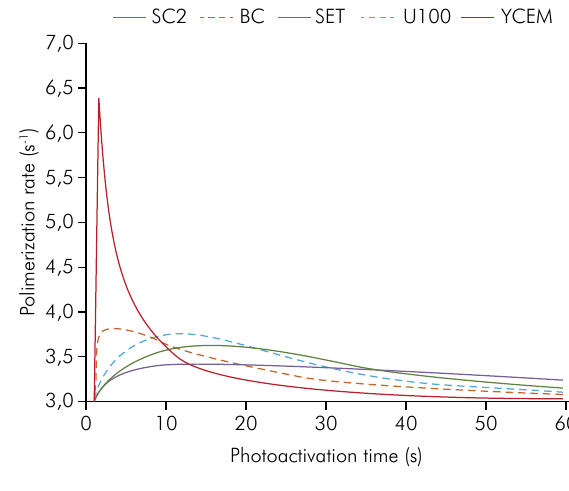
Figure 6. Polymerization rate of SARCs during photo- activation